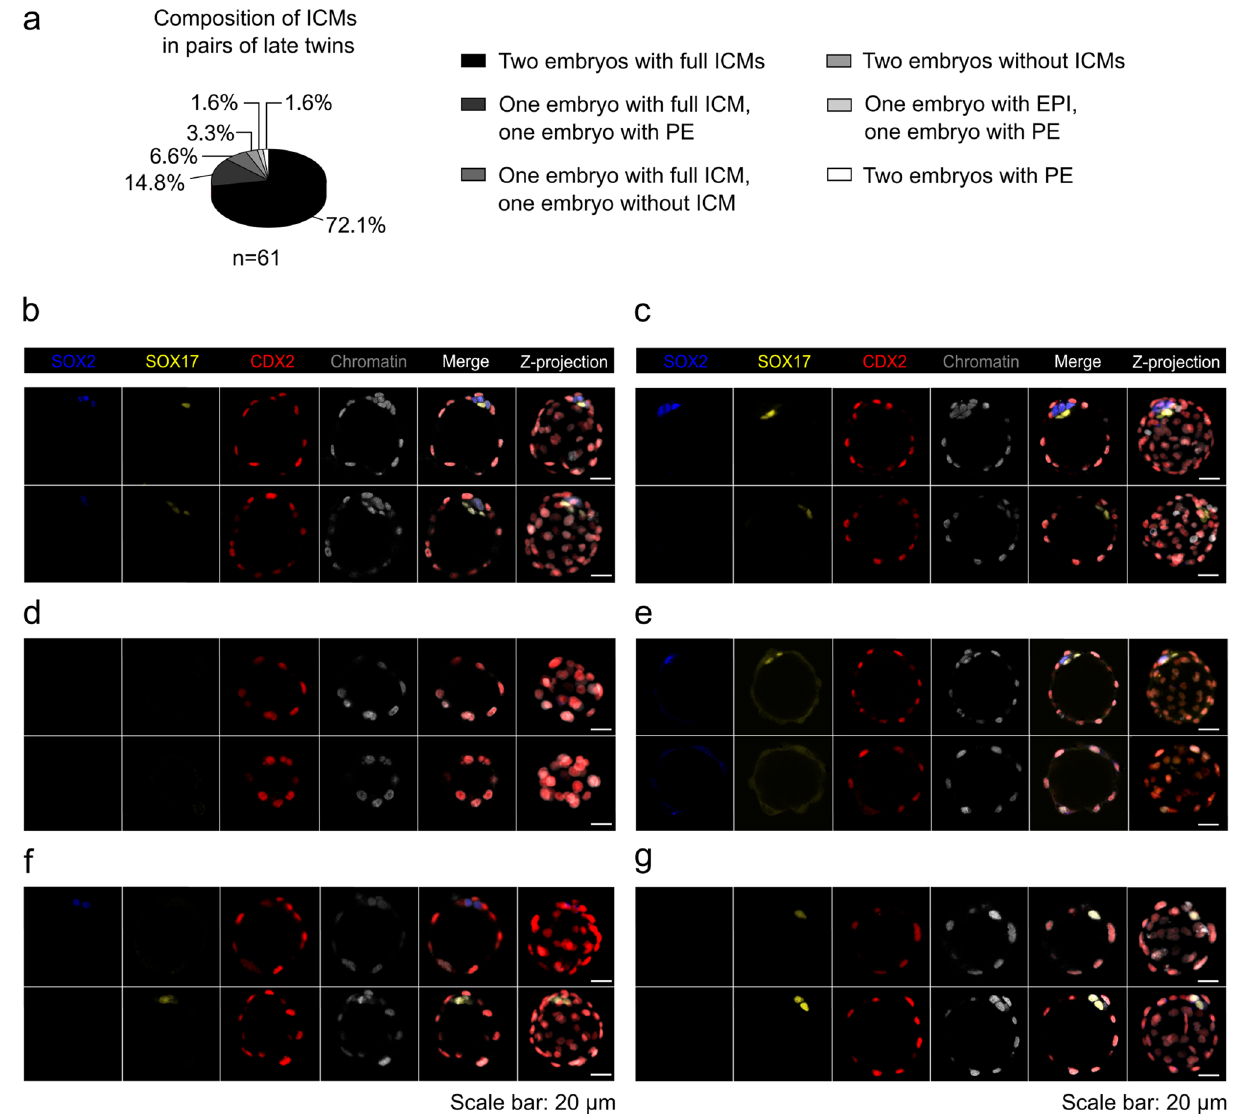
Figure 3. Potency of pairs of late twin blastocysts to generate inner cells. ( a ) Composition of ICMs in pairs of late twin blastocysts. ( b , c , d , e , f , and g ) SOX2 (blue), SOX17 (yellow), and CDX2 (red) immunolocalization in representative twin blastocysts. Chromatin (white) was labeled with chromomycin A 3 . The last panel corresponds to the average intensity projections of Z-stack images. Scale bar: 20 µm. A pair in which both embryos had ICMs consisting of EPI and PE cells is shown in ( b ). A pair in which one embryo created a complete ICM and the other formed only PE cells is presented in ( c ). A pair in which both embryos formed trophoblastic vesicles is shown in ( d ). A pair in which one embryo created a complete ICM and the other developed into trophoblastic vesicle is presented in ( e ). A pair in which one embryo contained only EPI and the other only PE cells is shown in ( f ). A pair in which both embryos had exclusively PE in their ICMs is presented in ( g pairs; 6.6%; Fig. 3a, e) developed into trophoblastic vesicles or into pairs in which one embryo contained only EPI and the other only PE cells (1 of 61 pairs; 1.6%; Fig. 3a, f). In the remaining one case, both twin embryos had exclusively PE cells in their ICMs (1 of 61 pairs; 1.6%; Fig. 3a, g). This analysis showed that the vast majority of monozygotic twin blastocysts derived from single blastomeres of 2-cell embryos were capable of generating ICMs consisting of EPI and PE progenitors/cells both in the early and late variations of the experiment. In addition, we found that embryos that reached the early blastocyst stage had slightly greater potential to form complete ICMs than embryos that developed into the late blastocyst stage. To investigate whether twin blastocysts differ in the number and proportion of cells of each cell lineage, we calculated the absolute value of the difference between the results obtained for each pair of experimental blastocysts. Using Student’s t-test for one mean, we compared the results obtained for twin blastocysts to the reference mean value and the standard deviation of these parameters in randomly matched pairs of blastocysts